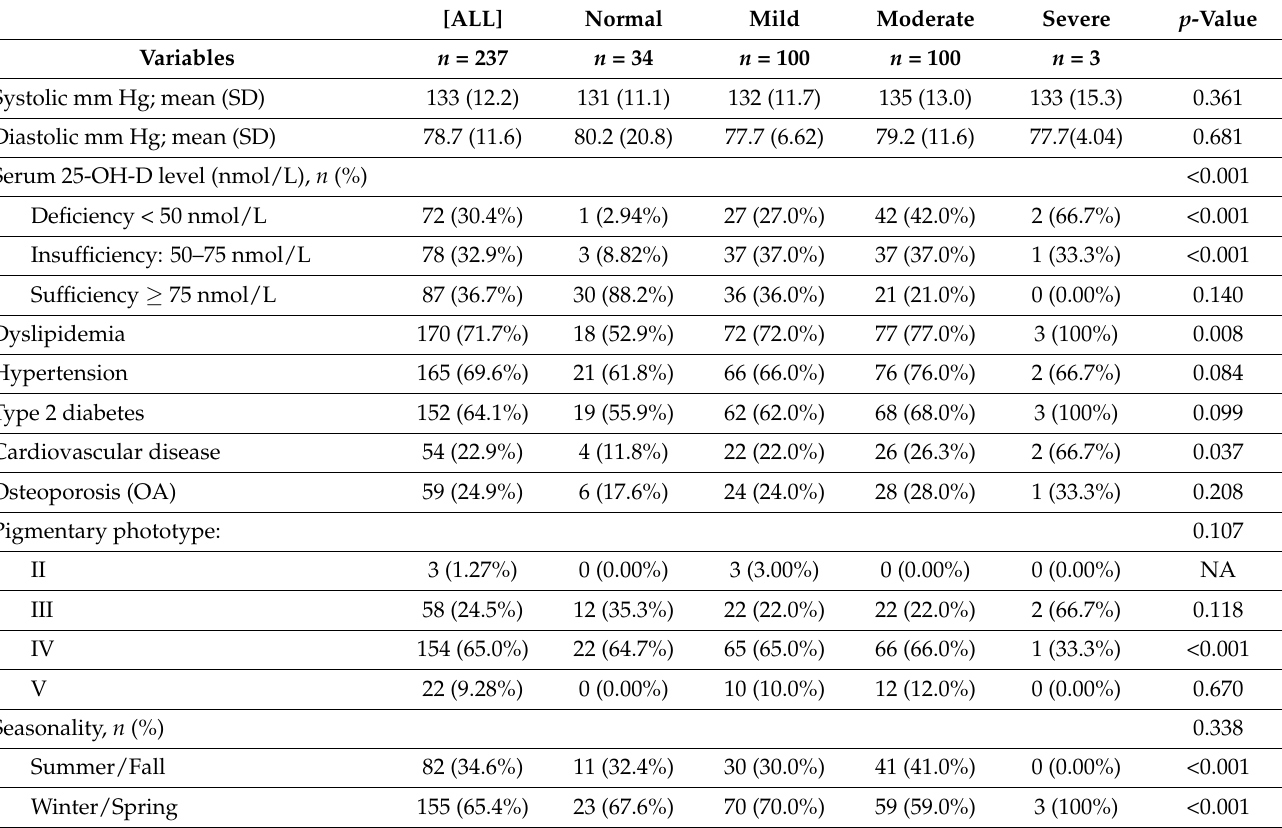
Table 2. Association between the Geriatric Depression symptom scale-15 (GDS-15), anthropometric measurements, and laboratory